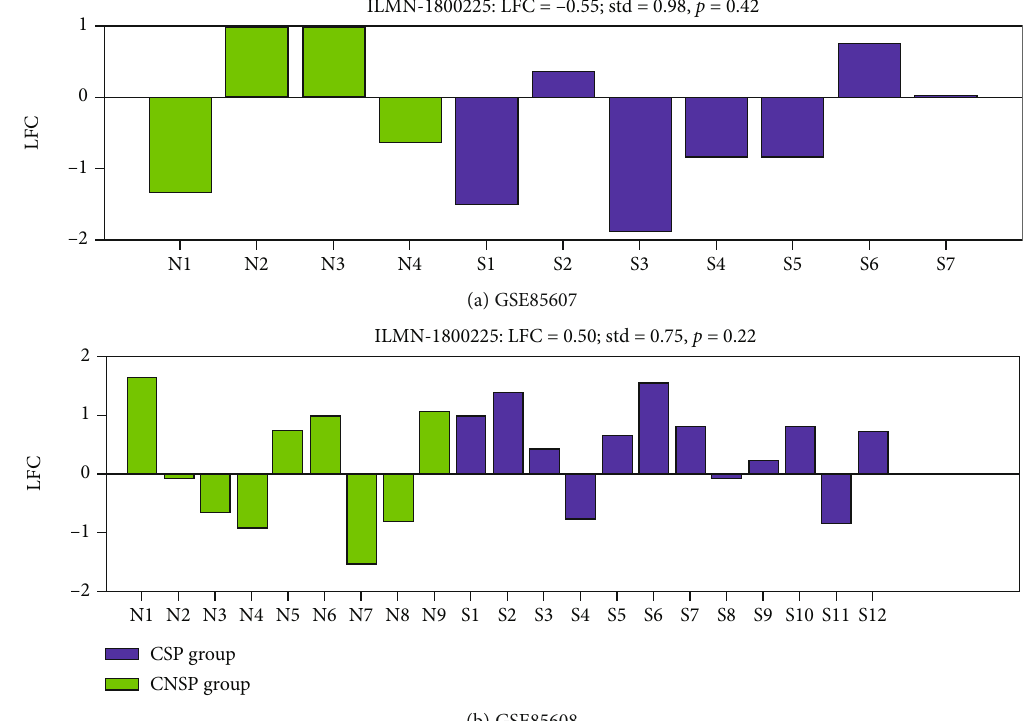
Figure 1: PPARG expression in terms of log fold change (LFC) in chemotherapy-sensitive patients (CSP) among all HSCC patients: (a) PPARG expression of HSCC patients in the dataset GSE85607; (b) PPARG expression of HSCC patients in the dataset